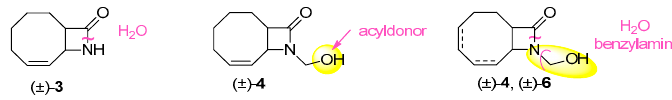
Figure 1. Substrates (±)- 3 , (±)- 4 and (±)- 6 in the enzymatic strategies planned.